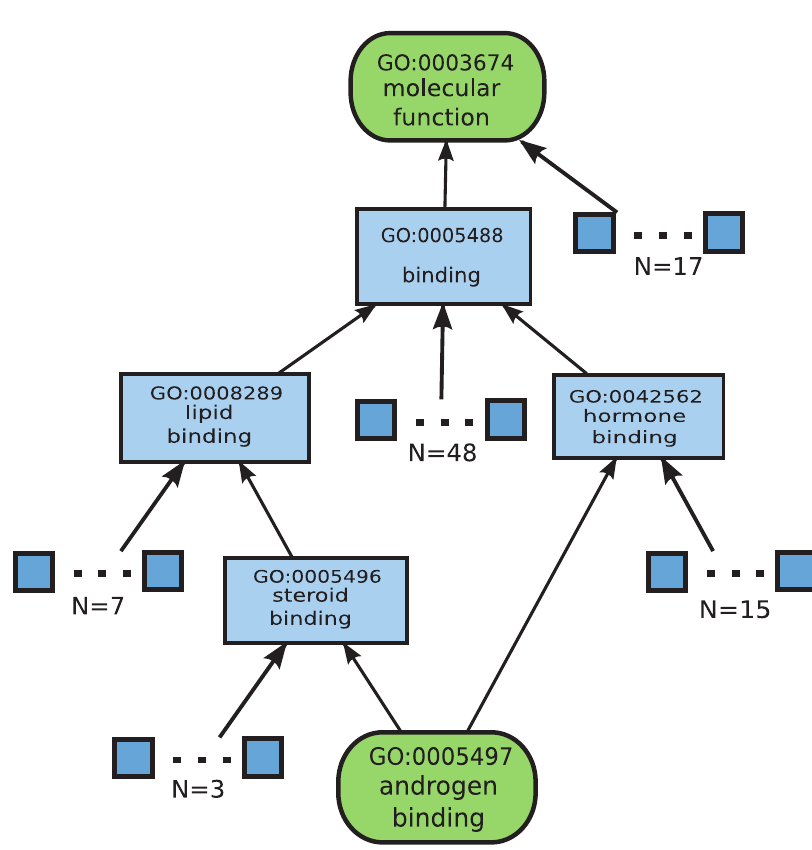
Figure 5. An example sub-graph of GO DAGs.